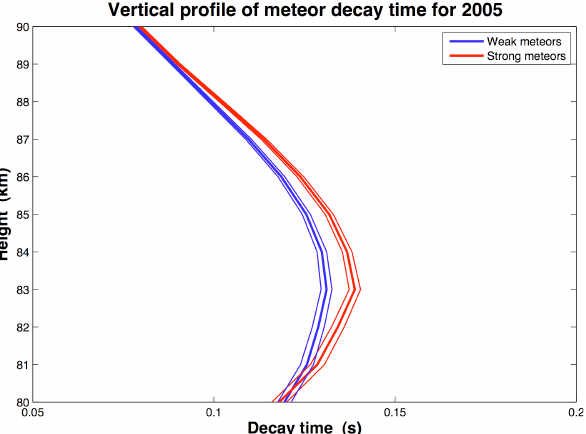
Fig. 2. Vertical profiles of mean decay time for 2005. The profile of weak meteors (SNR < 12dB) is shown in blue; strong meteors (SNR ≥ 12dB) in red. The thin lines either side of the mean profiles indicate the 99% confidence interval